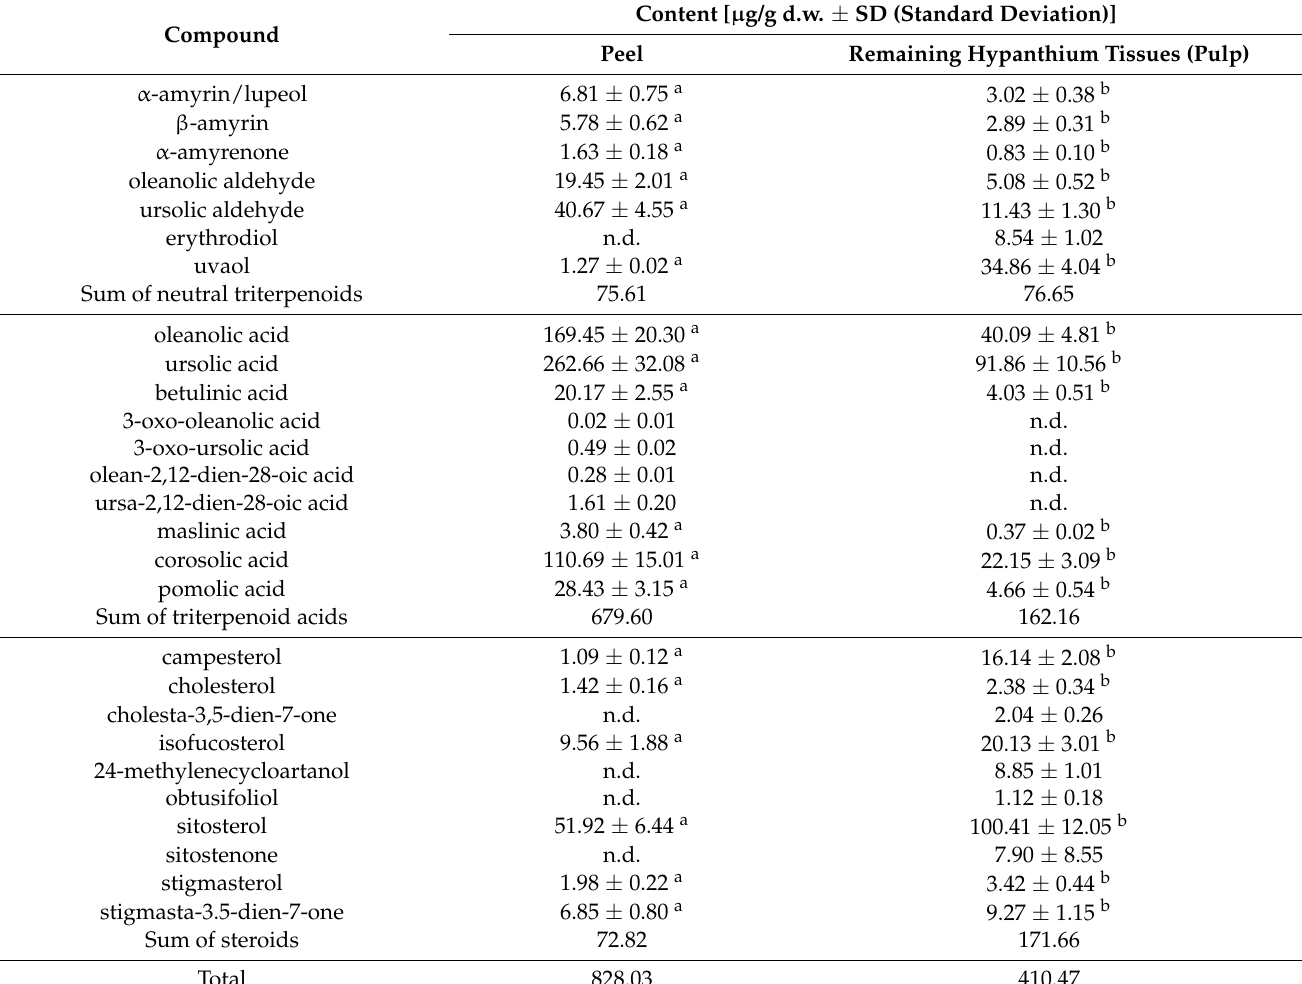
Table 3. Content of triterpenoids and steroids in isolated peel and remaining tissues of hypanthium of matured Rosa rugosa hip.